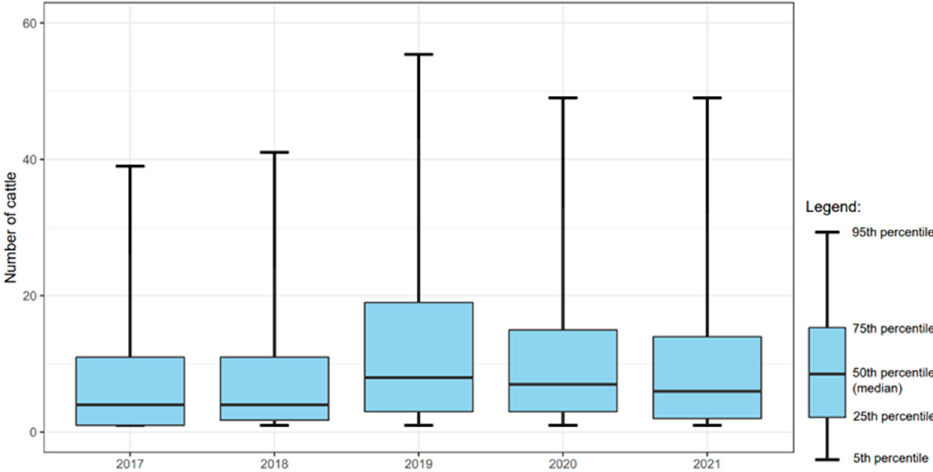
Figure 5. Box-and-Whisker plot of the numbers of introduced cattle per purchasing herd per year in